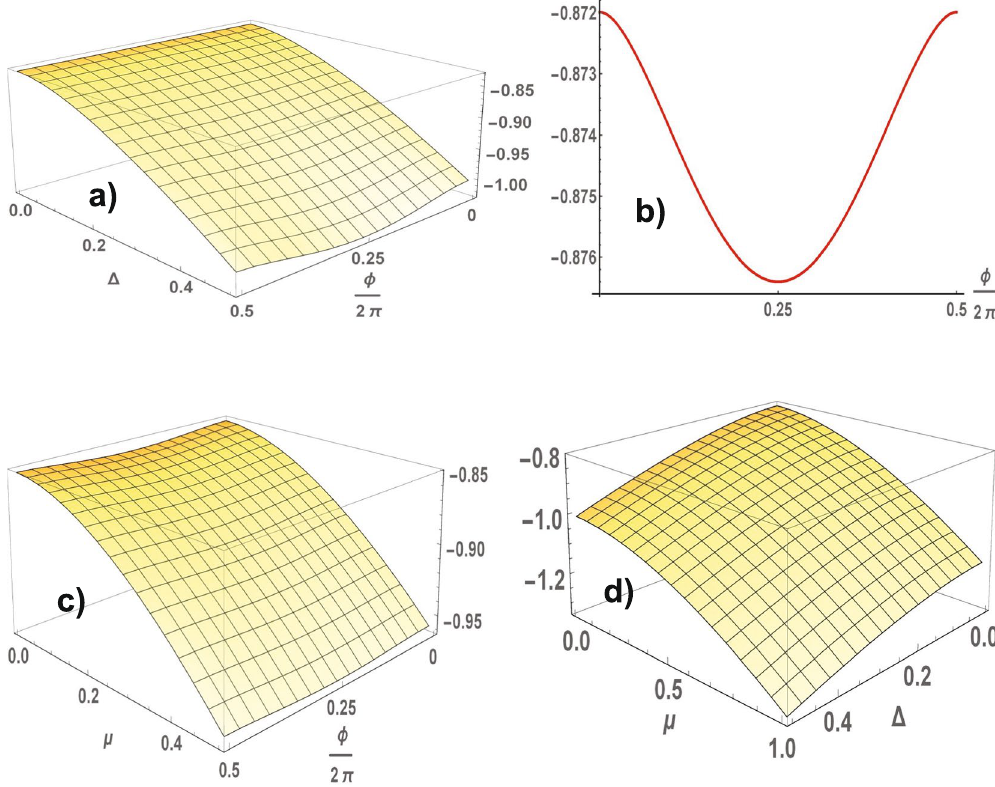
Figure 2. A square lattice. The ground state energy per atom as a function of the superconducting order parameter ( Δ , φ ) at μ = 0.2 ( a ), profile at Δ = 0.2 ( b ) and as a function of μ and φ at Δ = 0.2 ( c ). The ground state energy per atom of TSC as function of Δ and μ ( d